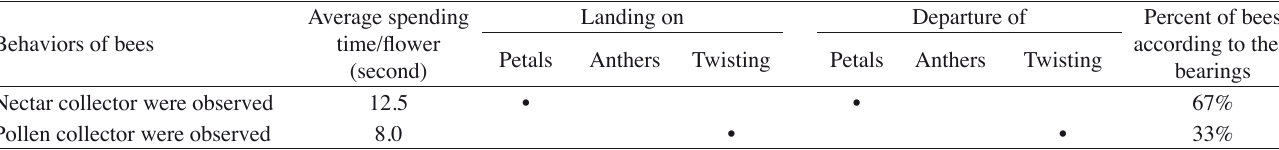
Behaviors of bees